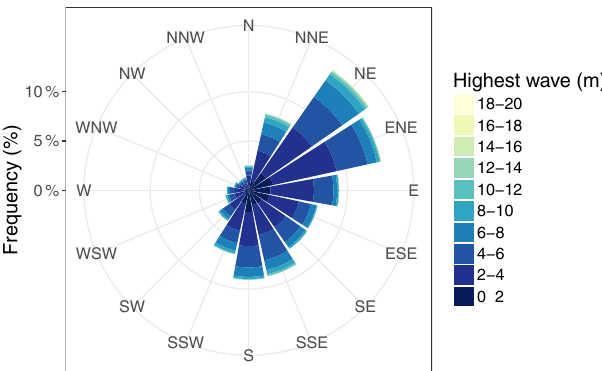
Figure 11. A frequency rose, showing the frequency (%) and height of highest wave (m) for different wave directions (22.5 ◦ bins), with wave directions defined in the same way as wind